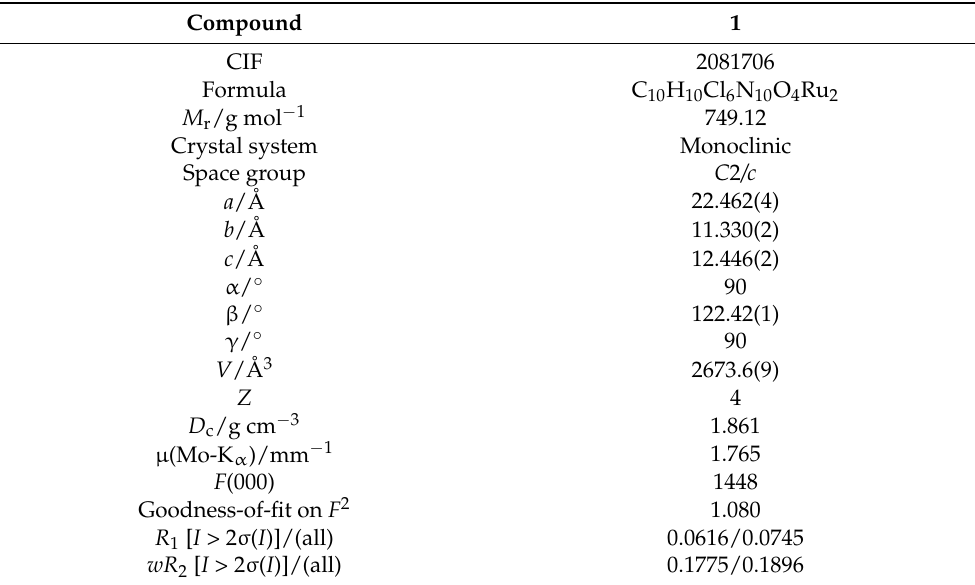
Table 1. Summary of the crystal data and structure refinement parameters for 1 (see Supplementary